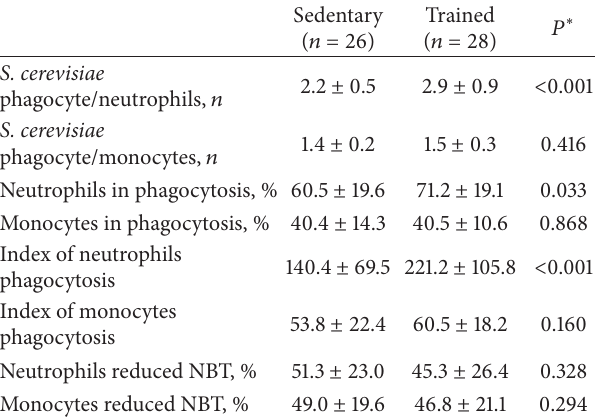
Table 1: Characteristics of the sample. Table 2: Phagocytic and oxidative activities in the samples.